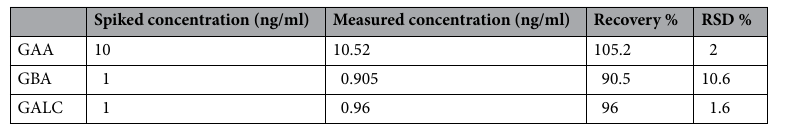
Table 1. Three human serum samples individually diluted 1:100, spiked with 10 ng/ml of GAA and 1 ng/ml of GBA and GALC, and the calculated recovery % and relative standard deviation (RSD %).